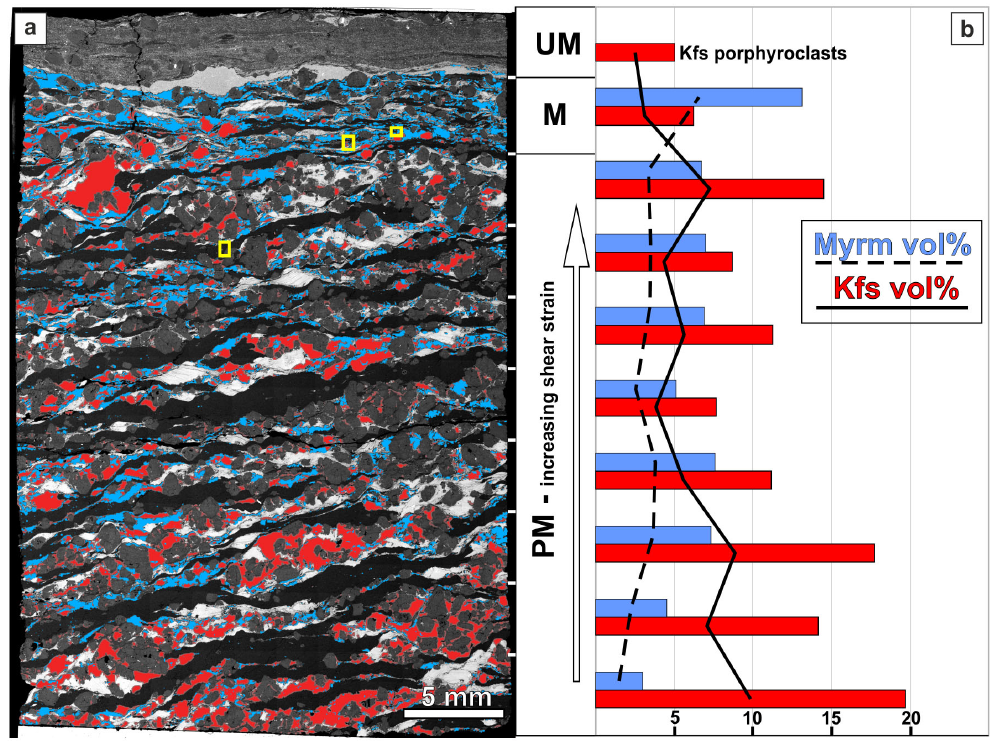
Figure 2. Phase distribution and abundance across a strain gradient in a granodiorite mylonite. (a) Mosaic of SEM-BSE images with the Kfs and the myrmekite + sheared myrmekite coloured in red and pale blue, respectively, and Qtz coloured in black. The yellow rectangles indicate the location of the EBSD maps of Figs. 3, 4, 5, and S2. (b) Bar diagram showing the volume amount of Kfs (red bars) and myrmekite (pale blue bars) across the microstructure: PM represents protomylonite; M represents mylonite; and UM represents